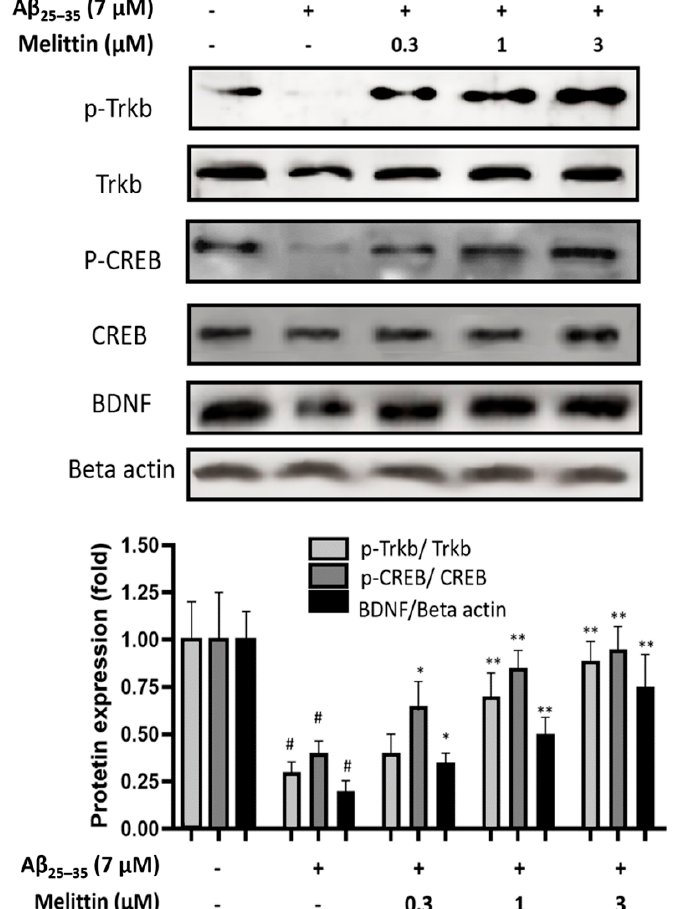
Figure 5. Effects of melittin on the activation of brain-derived neurotrophic factor signaling. The result suggested that melittin enhanced the performance of the BDNF/TrkB/CREB pathway under A β 25–35 (7 μ M) challenge. To conduct this experiment: Seven hours after A β 25–35 (7 μ M) challenge, cells were lysed, and western blot was performed. Data are presented as mean ± standard deviation values of triple determinations. # p < 0.01, vs. control * p < 0.05, ** p < 0.01, vs. A β 25–35 only-treated group.